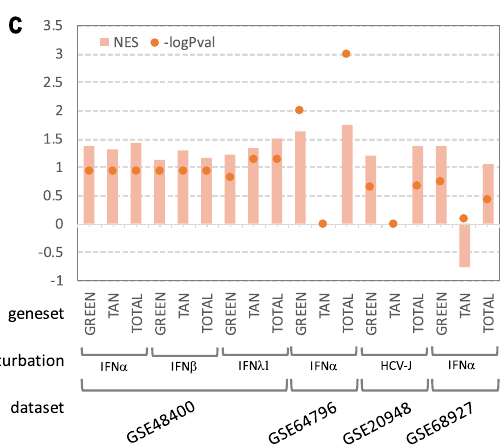
Figure 5. New IFN-stimulated signature is confirmed as ISGs with GSEA. ( a ) GSEA running sums showing the enrichment of custom geneset obtained by the combination of the Green and Tan modules in the Boolen et al. 2014 datasets (GSE48400) after 12 h of induction with IFN alpha, beta and lambda1. ( b ) Venn diagram of overlapping genes belonging to the leading edges of the three GSEA analyses in the previous panel. Seven genes (DNPEP, REC8, GRINA, CYTH1, PCK2, NME7, SIDT1) have been consistently found upregulated after different IFNs induction. ( c ) Normalized enrichment scores (NES) and relative GSEA p-Values for all sets of performed GSEAs (for datasets with more time points the 12 h point was selected and plotted). Dashed horizontal line is the standard GSEA significant cutoff: enrichments whose p -Value is above the dashed line are thus significant. Green, Tan and Total refer to genesets from Green module, Tan module and the combination of the two,